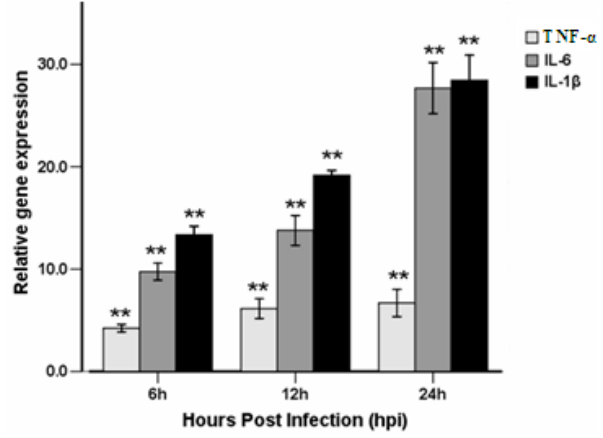
Figure 8. Effect of injection time for the genes expressions of inflammation cytokines by RT-PCR. Expressions of TNF- α , IL-6, and IL-1 β gene in 0.5 mg/mL LPS-infected larvae compared with controls determined by quantitative real-time PCR. Larvae were injected with 0.5 mg/mL LPS at 3 dpf. Total RNA was extracted from larvae at 6, 12, and 24 hpi. Each bar represents the mean of three replicates. Error bars represent standard